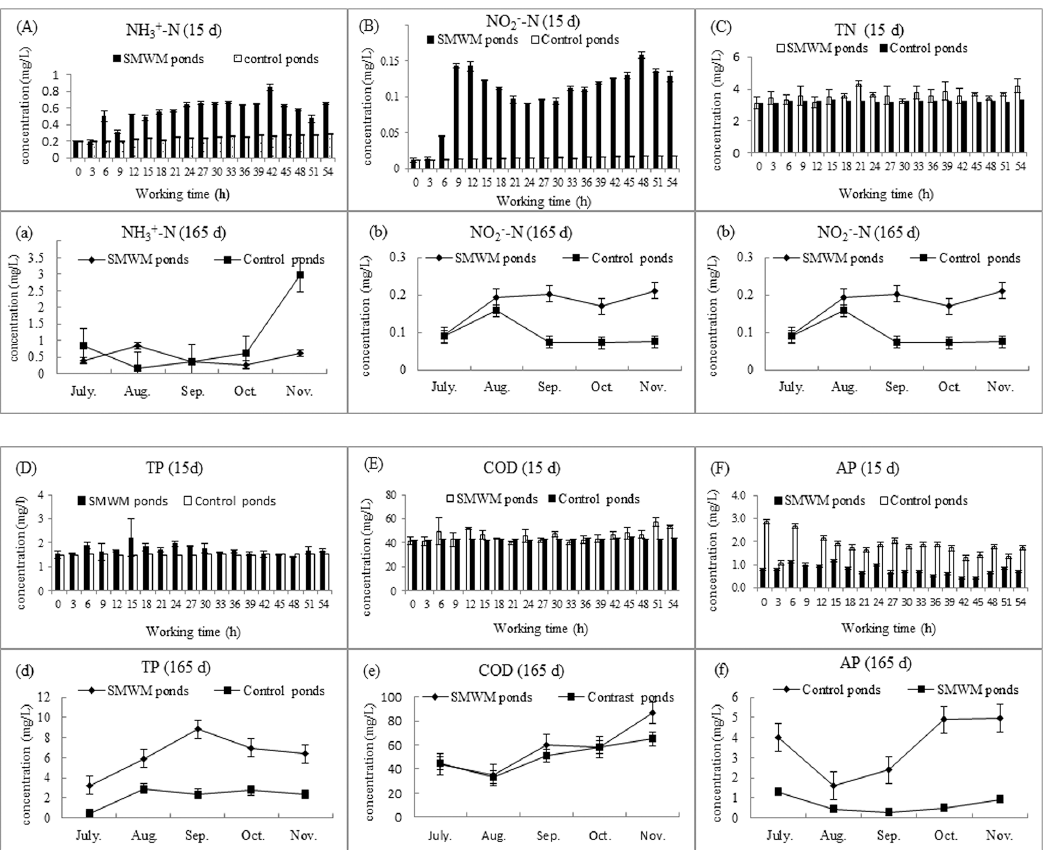
Fig 8. The influence of SMWM on bream culture pond water quality. (A),(B),(C),(D),(E) and (F) were the concentrations of NH 4+ – N, NO 2 − – N, TN, TP, COD Mn and AP in used SMWM ponds and control ponds water at the beginning 15 days (From June 1 to June 15, 2013 the SMWM operation 54 hours). (a), (b),(c),(d),(e) and (f) were the concentrations of NH 4+ – N, NO 2 − – N, TN, TP, COD Mn and AP in used SMWM ponds and control ponds water in 165 days (From June 1, 2013 to November 15,